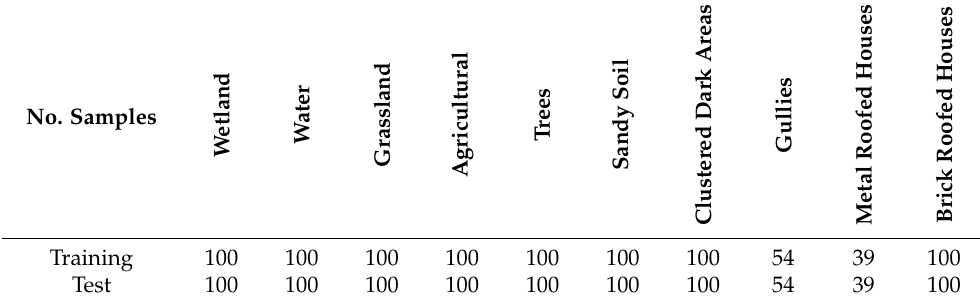
Table 4. Number of sample objects of training and test